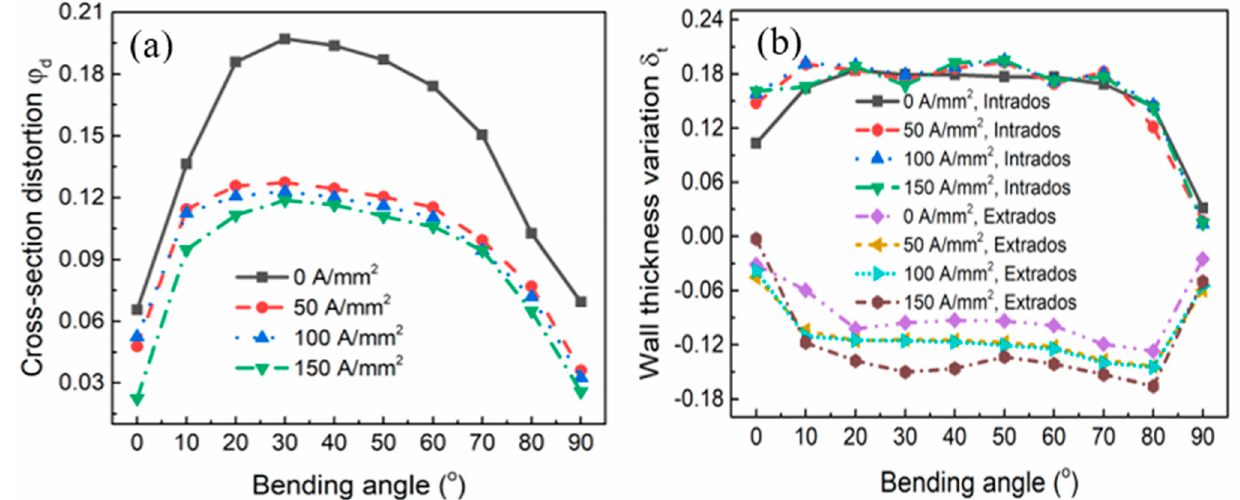
Figure 11. Effects of current density on ( a ) cross-section distortion and ( b ) wall thickness variation at different bending angles in EA RDB of micro-tubes.